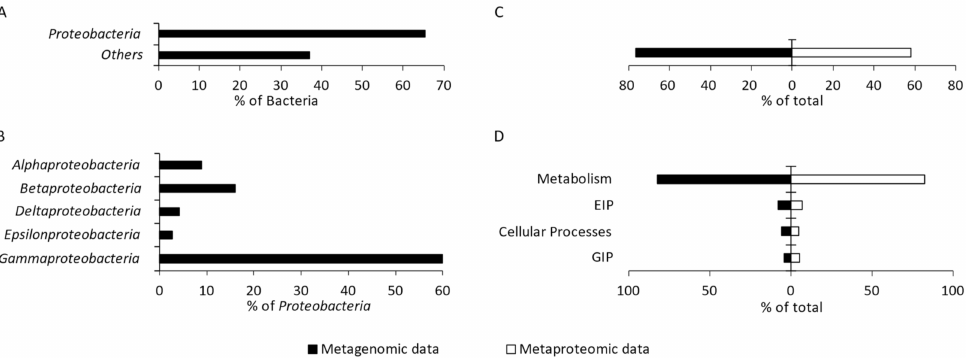
Figure 2. Percentage of Proteobacteria in the studied microbial community ( A ). Diversity and per- centage of the identified proteobacterial classes (>1%) ( B ). Percentage abundance of proteobacterial KO (KEGG Orthologs) obtained from metagenomic and metaproteomic data among all identified bacterial KO ( C ). Number of proteobacterial KO representing four main functional categories; EIP— environmental information processing; GIP—genetic information processing ( D